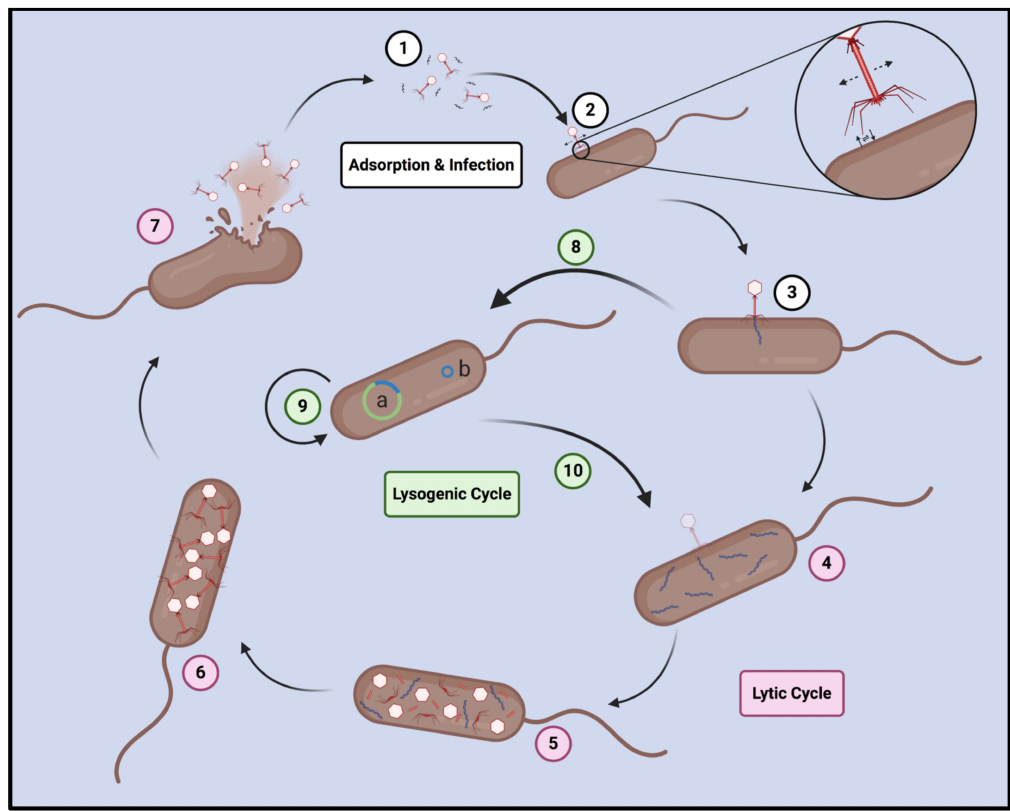
Figure 3. Replication cycle of Caudovirales bacteriophages. All phages of the order Caudovirales replicate through two complementary cycles. Prior to infection, phage particles are propelled through medium by random electrostatic interactions with nearby molecules ( 1 ) until they reach a bacterial host cell, whereupon they adsorb to its surface by using their tail fibers and subsequently utilize the spontaneous binding and unbinding of these tail fibers to engage in a random walk across the cell surface ( 2 ). Upon interacting with its cognate secondary receptor, the phage infects the cell by injecting its genetic material ( 3 ) and is then compelled to proceed with one of two possible replication cycles. In the lytic cycle, which is normally employed when host cell density is high, the phage genome is replicated ( 4 ), transcribed and translated into the components of the phage particles ( 5 ), which are then assembled within the cell ( 6 ). Finally, the host cell is lysed ( 7 ), and liberated progeny phages are able to subsequently infect additional cells. In the alternative lysogenic cycle, which is often employed when host cell density is low, the phage genome is either integrated into the bacterial genome ( 8a ) or circularized into a phagemid ( 8b ), and this prophage then forms replicates passively along with its lysogenized host ( 9 ). Deterioration of host cell conditions due to starvation or other stressors may cause induction of the prophage, whereupon it returns to the lytic cycle ( 10 ) and ultimately destroys its host cell via